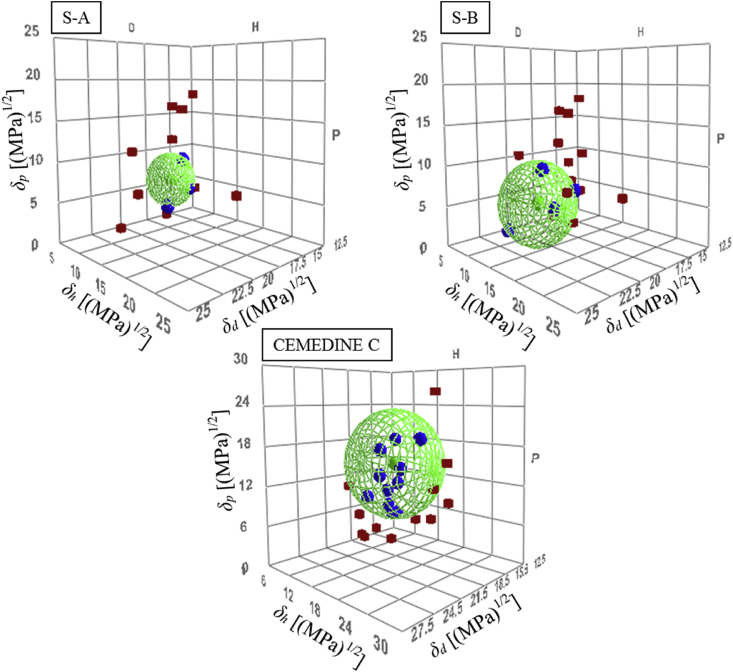
HSP 3D diagram of each resins with HSPs of organic solvents used in this work. Blue balls are “good” solvents, and red cubes are the “poor” solvents: (S–A) Hansen solubility sphere of S-A, (S–B) Hansen solubility sphere of S–B (CEMEDINE C) Hansen solubility sphere of CEMEDINE C.